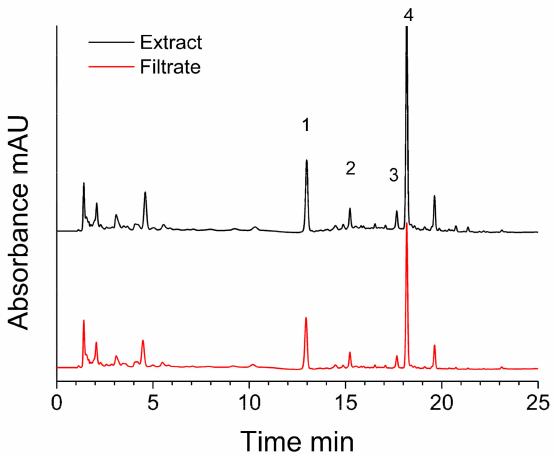
Figure 1. The chromatogram of Gnetum parvifolium extract (black) and filtrate after ultrafiltration (red). High-performance liquid chromatography-mass spectrometry (HPLC-MS) analysis is then